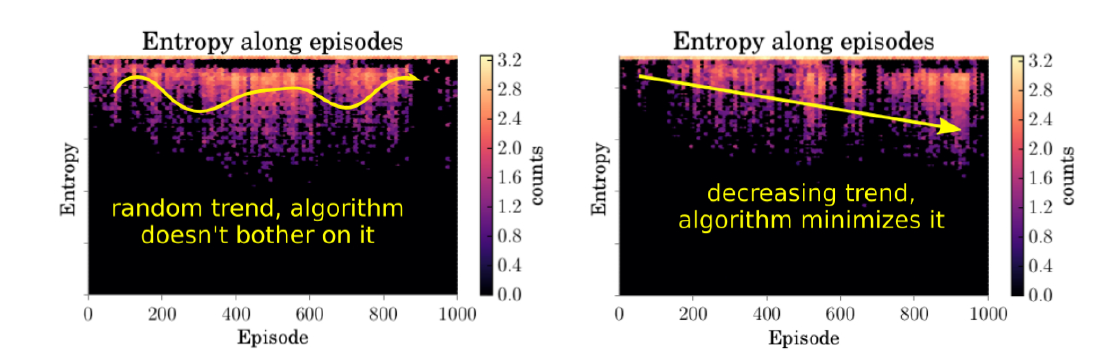
Figure 3. Logarithmic occurrence of entropy along episodes in the second scenario. Results are shown for traditional ( left ) and uncertainty-based ( right ) RL’s reward functions. Darker colors denote lower occurrence.